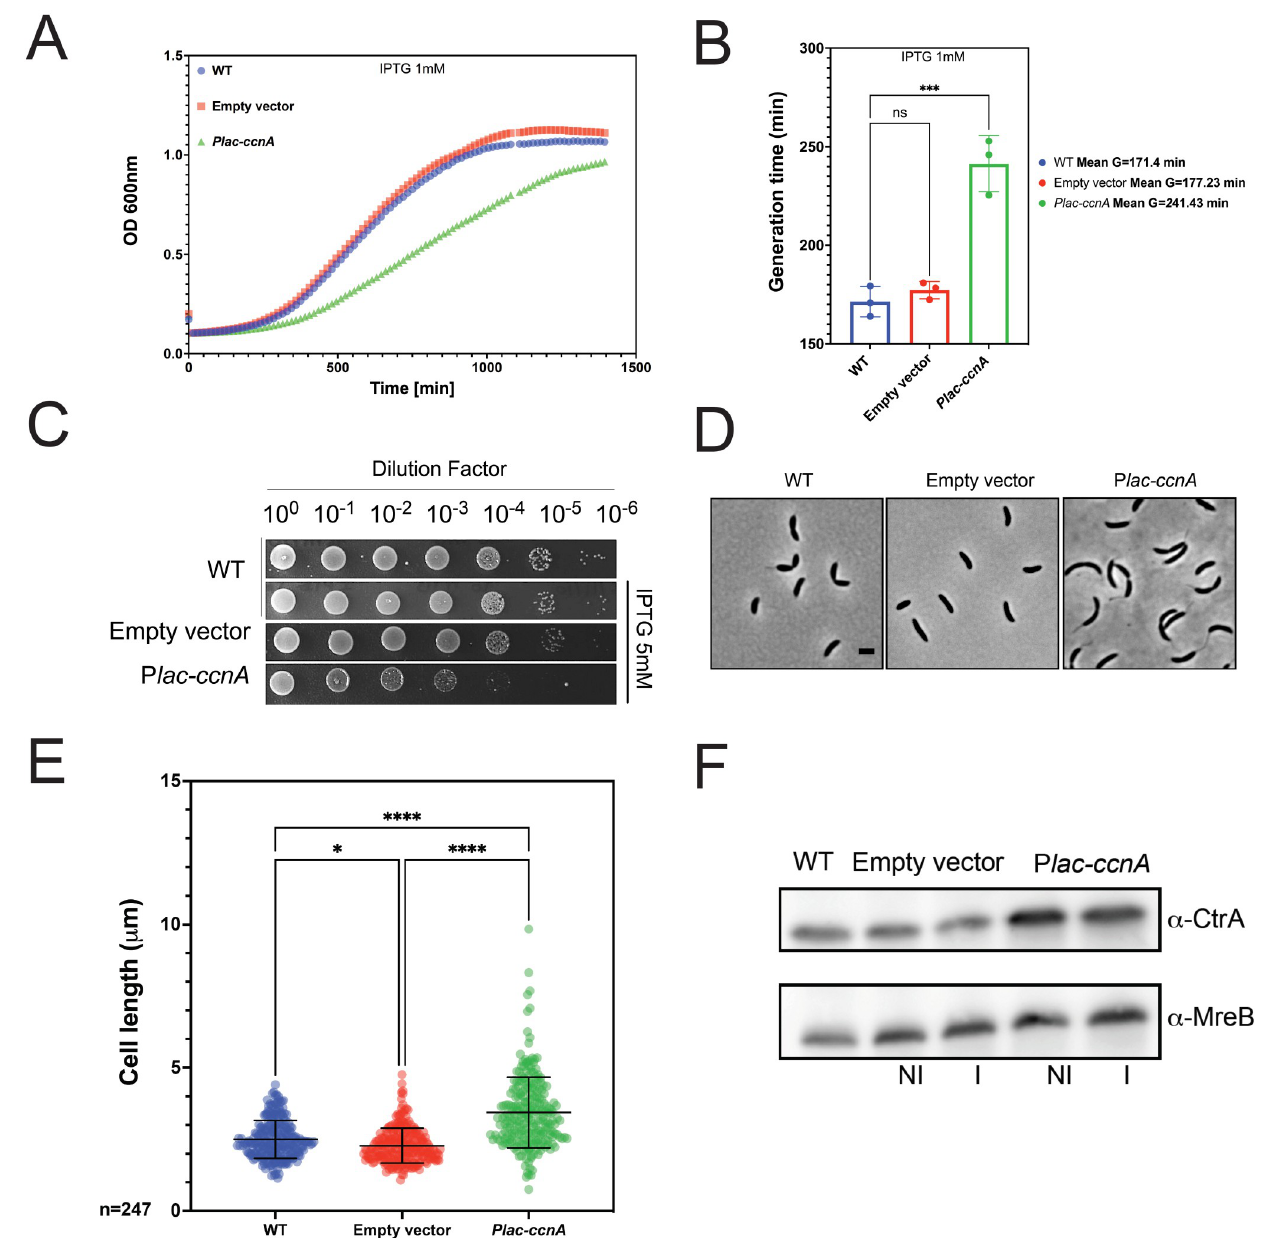
Fig 2. CcnA affects the cell cycle. (A) Growth curves following the expression of CcnA . WT cells and WT cells carrying either an empty pSRK (empty vector) or a pSRK with ccnA under the control of an inducible P lac promoter (P lac-ccnA ) were grown in PYE without IPTG. A volume of 200 μ L of cells back-diluted from stationary phase cultures to an OD 600nm = 0.02 were then grown on 96 wells in PYE supplemented with 1 mM IPTG. Cell growth was monitored overnight with a Spark-TM at 30˚C and a shaking (orbital) amplitude of 6 mm and a shaking (orbital) frequency of 96 rpm. Results are shown as mean N = 3 biological replicates with 3 technical replicates. Raw data are provided in S7 Table. ( B) Determination of the doubling time of cells expressing CcnA . Doubling times of cells from (2A) were calculated by using the exponential growth equation (nonlinear regression) (Prism GraphPad 9.1.2). Statistical analysis was performed using ANOVA with a Brown–Forsythe and Welch ANOVA tests and a Dunnett’s multiple comparisons test. ns, difference not significant, ��� : p.val = 0,0002. Data are in S9 Table. ( C) WT cells, WT cells carrying either an empty vector or P lac-ccnA were grown overnight in PYE at 30˚C and diluted to an OD 600nm = 0.6. Samples were then serially diluted (10 0 –10 − 6 ) and 4.5 μ L of each dilution were spotted on a PYE-Agar + 5 mM IPTG plate and incubated at 30˚C. WT cells without plasmid were used as negative control. ( D) Phase contrast images of WT cells, WT cells carrying an empty vector or P lac-ccnA grown in PYE without IPTG until OD 600nm = 0.6. Scale bar = 2 μ m. ( E) Cells from (2D) were analyzed using MicrobeJ [37] to assess cell length. Approximately 247 cells were analyzed for each condition, and statistical significance was determined using ANOVA with Tukey multiple comparisons test. � : p.val = 0.0168 ���� : p.val < 0.0001. Raw Data are provided in S8 Table. ( F) WT cells, WT cells carrying an empty vector or Plac-ccnA were grown in PYE at 30˚C until OD 600nm = 0.6. Then, induction of P lac-ccnA was made by addition of IPTG 1 mM 30 min. As a